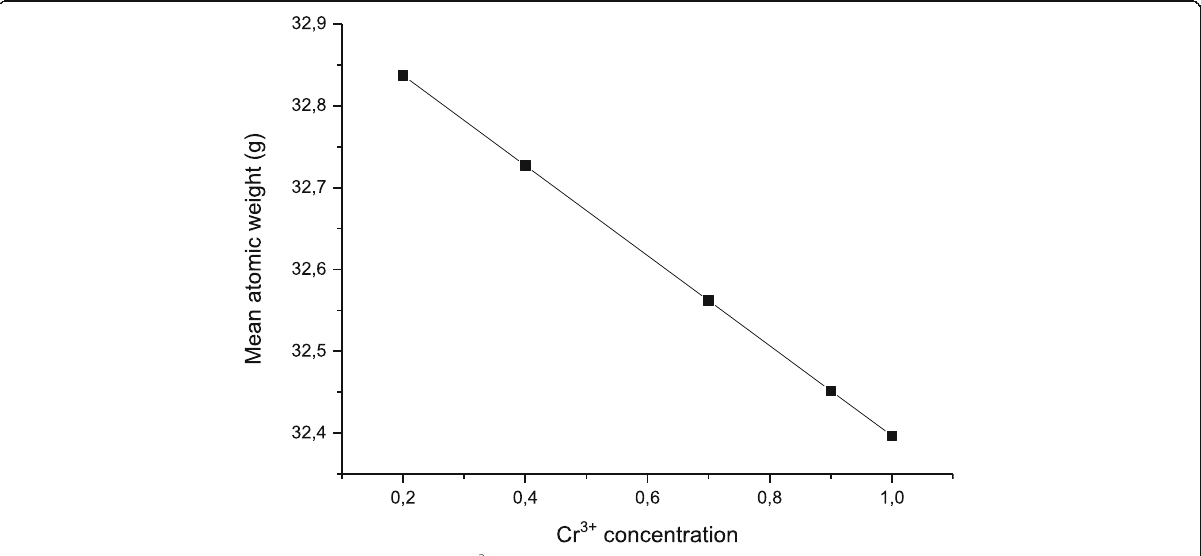
Fig. 5 Variation of the mean atomic value with varying Cr 3+ ion concentration